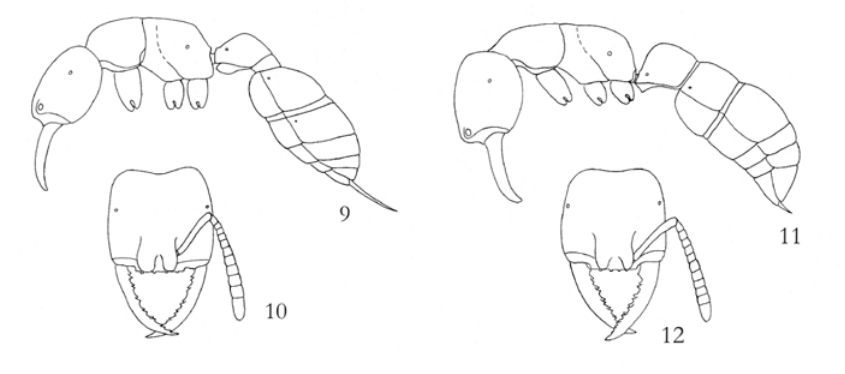
Figs. 9-12. 9-10: Worker of Amblyopone eminia Zhou; 9. Head and body in profile view; 10. Head in full-face view. (Cited from Zhou 2001, slightly modified). 11-12: Worker of Amblyopone rubiginoa Wu et Wang; 11. Head and body in profile view; 12. Head in full-face view. (Cited from Wu & Wang 1992, slightly